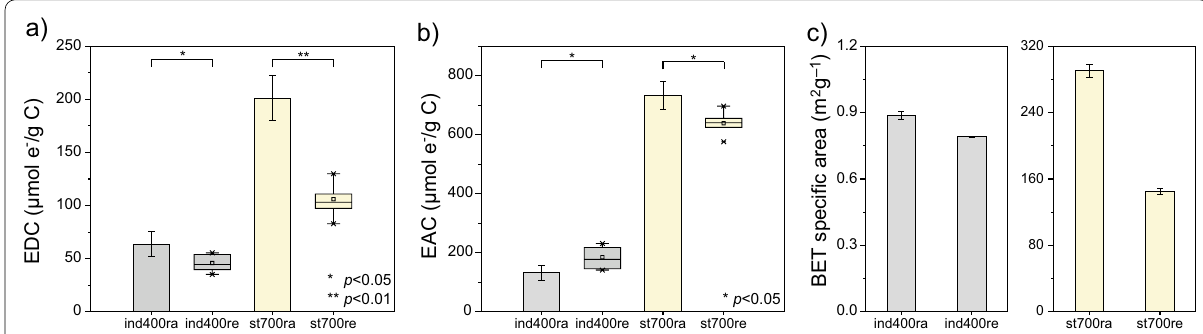
Fig. 5 EEC (EDC and EAC) and BET specific area of raw chars and residual chars. The prefixes, “ind” and “st”, represent the chars pyrolyzed from indigo dye and starch, respectively. The numbers in the middle indicate the pyrolysis temperature. The suffixes, “ra” and “re”, represent raw chars without treatment and residual chars after exfoliation,